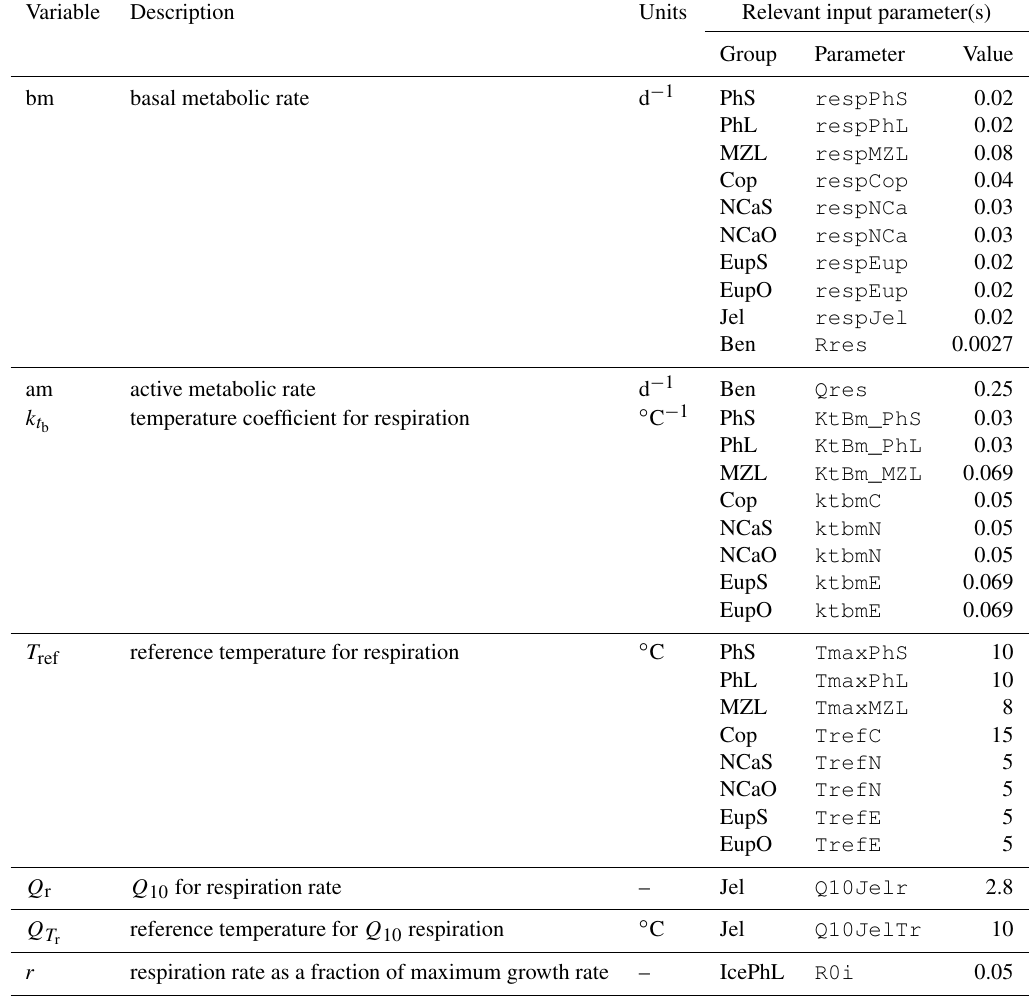
Table A9. Notation and description for input parameters related to respiration. (See Table A6 for pelagic prey preferences and infauna Q 10 parameters, Table A8 for infauna excretion fraction parameters, and Table A5 for ice algae growth rate parameter.)